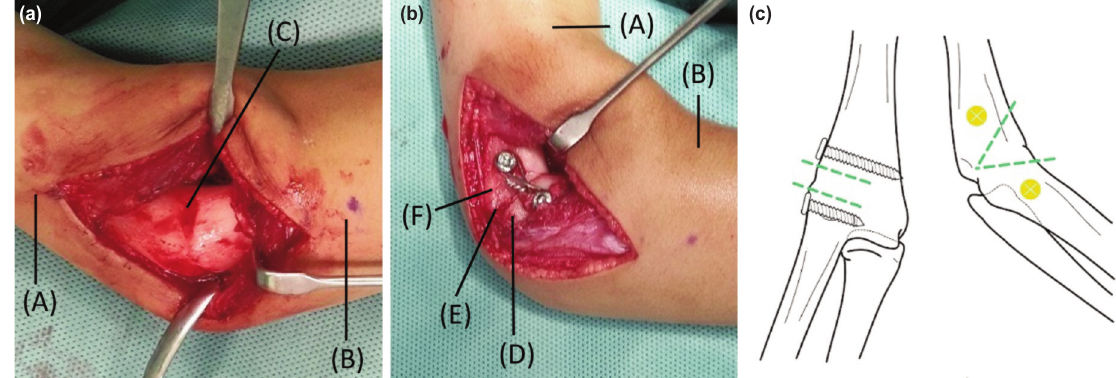
(a and b) Intra-operative photographs and (c) illustration of the right elbow osteotomy. (a) Right elbow photographs showing Fig. 2: the humeroradial synostosis before osteotomy and (b) after completion of the French osteotomy and fixation. (c) Illustration of the right elbow showing plane of osteotomy and fixation in antero-posterior position and lateral position. * (A) Right arm; (B) right forearm; (C) humeroradial synostosis (D) right radius; (E) site of osteotomy; (F) right